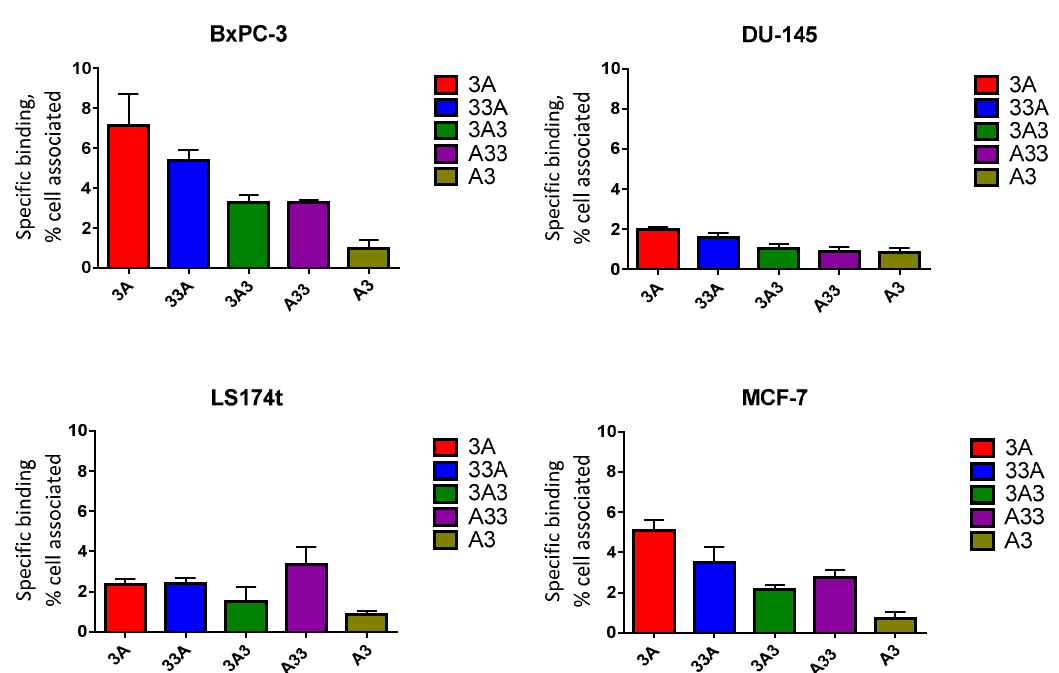
Figure 4. Specific binding (total binding subtracted with the binding after receptor saturation) of different 111 In-labelled ABD-fused anti-HER3 affibody molecules to HER3-expressing cells (BxPC-3, DU-145, LS174T, and MCF-7) in vitro. Data are presented as an average ± SD ( n = 3) for the percentage of cell-bound radioactivity from totally added radioactivity.